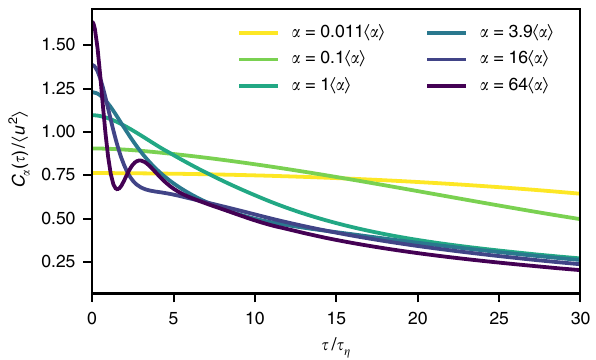
Fig. 4 Conditional velocity autocorrelation functions. The conditional correlation functions on α re fl ect the strongly varying fl ow conditions for different values of α . The higher α , the faster the velocity of tracer particles decorrelates. Velocity oscillations observed for high values of α in Fig. 2d result in a secondary maximum in the corresponding correlation